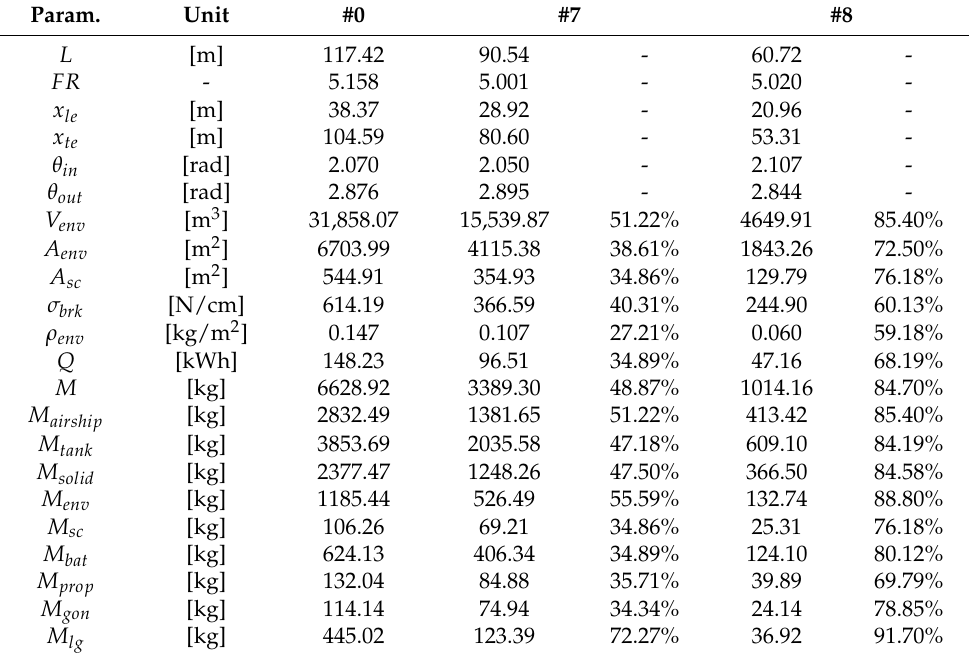
Table 15. Effect of technological advancements and design improvements on optimal design for operation at 20 km altitude above L’Aquila, Italy (Part 4). For each case, the first column gives the absolute value of the parameter, while the second column gives the percent reduction compared to the baseline #0.